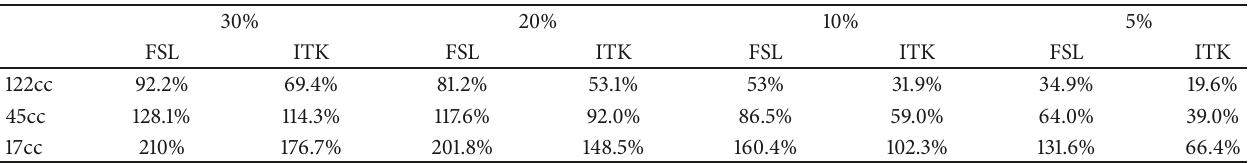
Table 1: Ratios of synthetic infarctvolume and the corresponding measured volume as a function of changes in volume (three volumes at left) and different radiodensities (four densities across the top of the columns) for the two different IIC algorithms (FSL and ITK). The numbers correspond to Figure